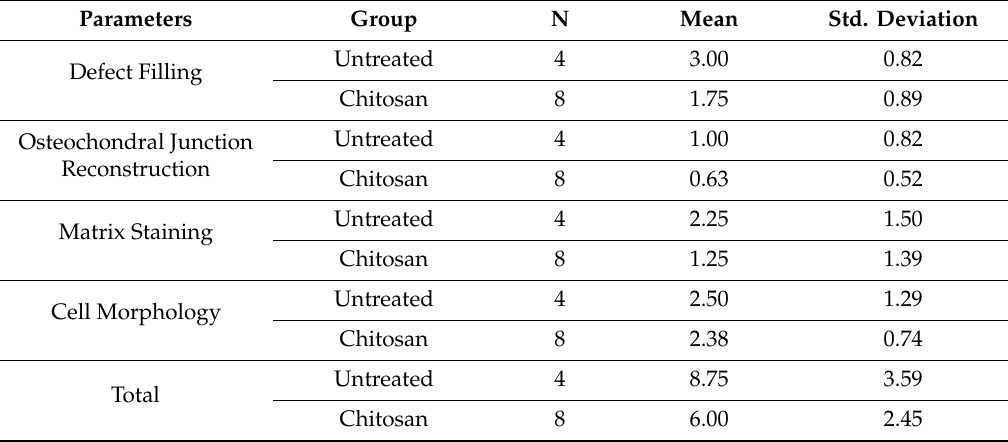
Table 2. Pineda histology score results. All p values >